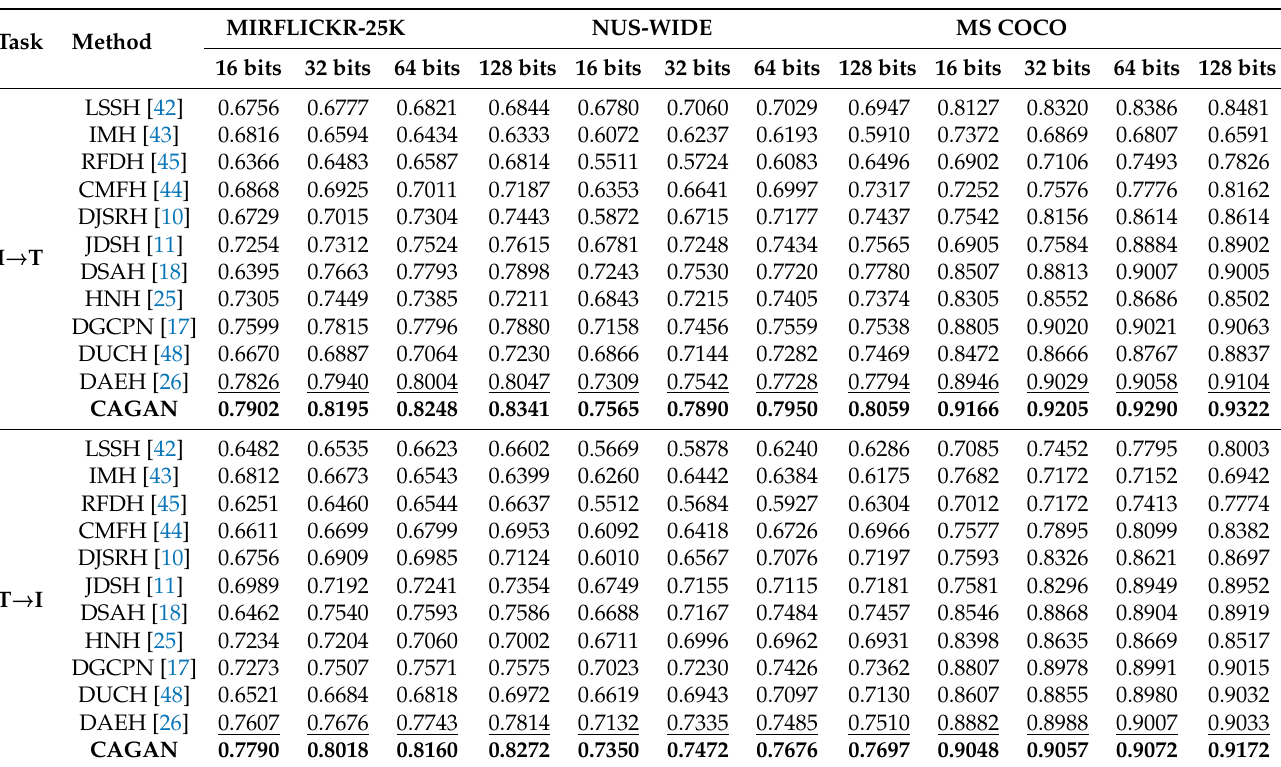
Table 2. The MAP@5000 results on cross-modal retrieval tasks (I → T indicates the image search text task and vice versa) and three benchmark datasets. The best outcomes are highlighted in bold, and sub-optimal results are